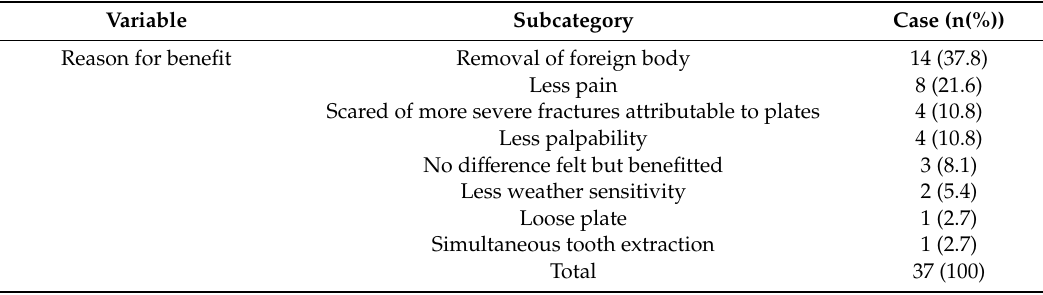
Table 14. Reasons for individual benefit of plate removal from the patient’s point of view. The removal of a foreign body in situ was the most common reason. Totals of the percentages may not be exactly 100% because of